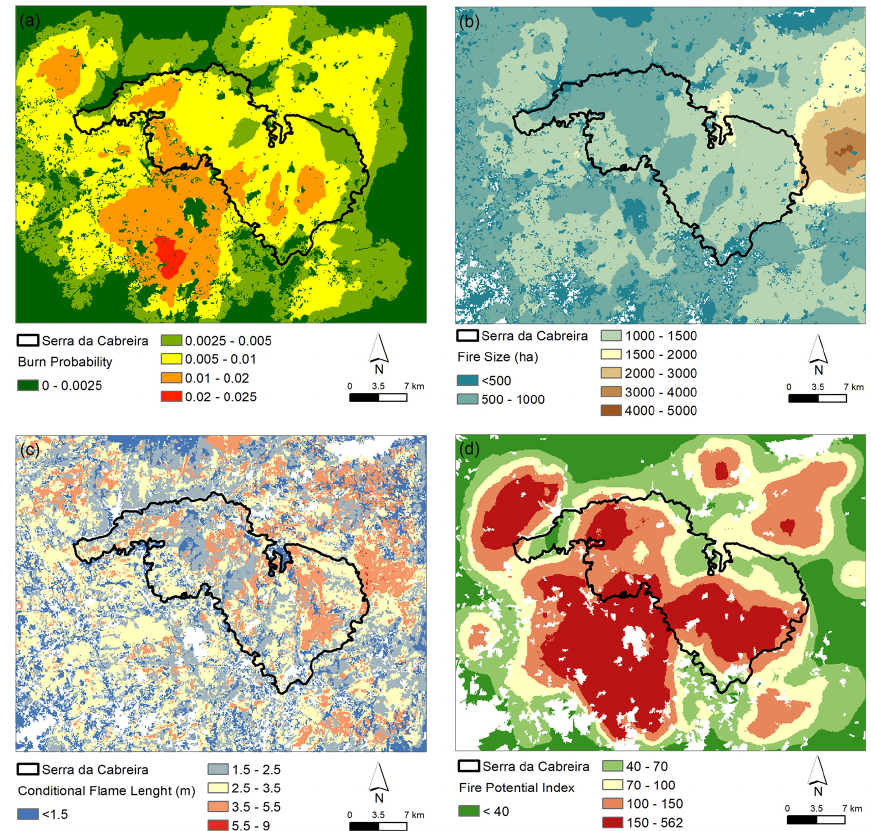
Figure 3. Wildfire descriptors estimated with the extreme weather fire spread simulations: (a) burn probability (BP), (b) fire size (FS), (c) conditional flame length (CFL) and (d) fire potential index (FPI). FPI is shown in 20th percentile